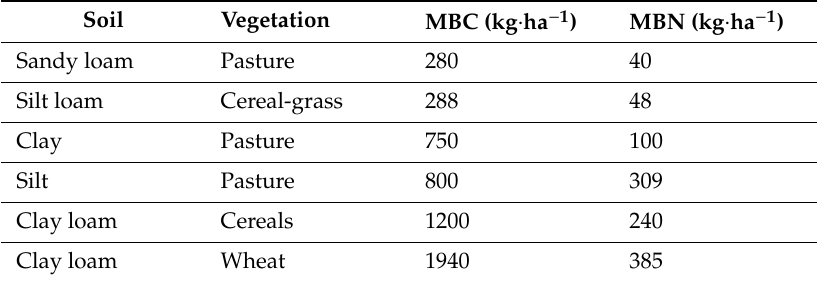
Table 1. Some values of microbial biomass C (MBC) and microbial biomass N (MBN) in soil (redrawn from Smith and Paul 1990,